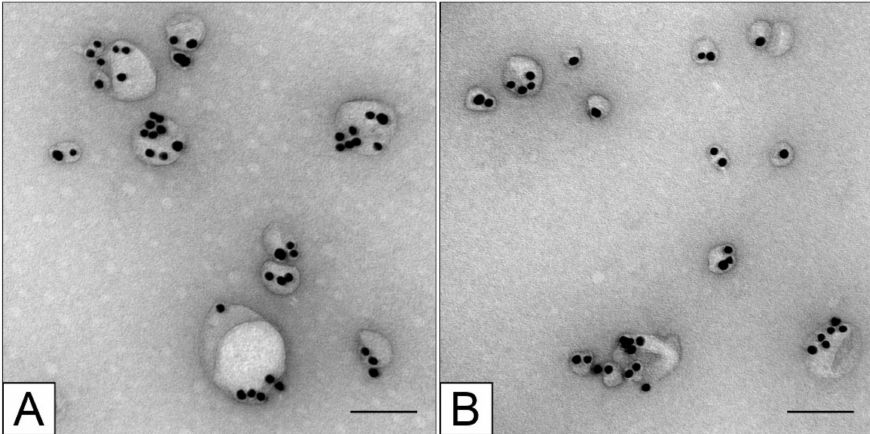
Figure 4. Ultrastructure of MLNCs carrying ( A ) unmodified or ( B ) modified siRNA (As-OMe/S). Negative staining with 0.5% uranyl acetate (TEM). Scale bars correspond to 100 nm.